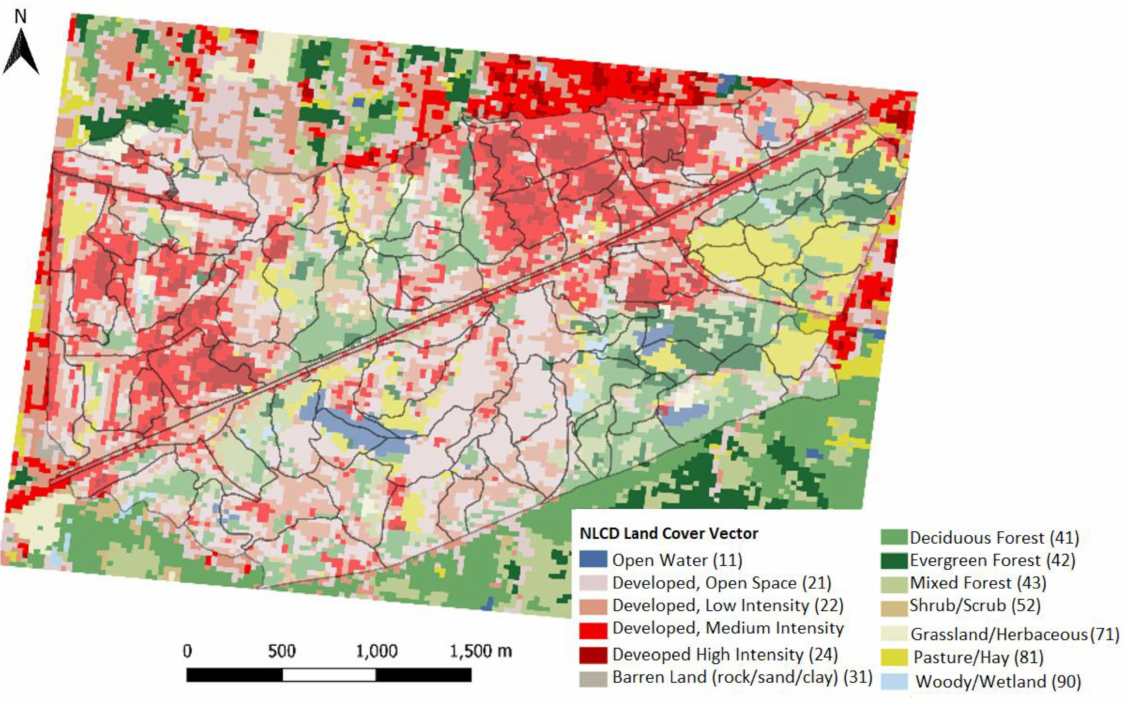
Figure 2. NLCD Land Cover map of selected research area at the Moore’s Mill Creek watershed.